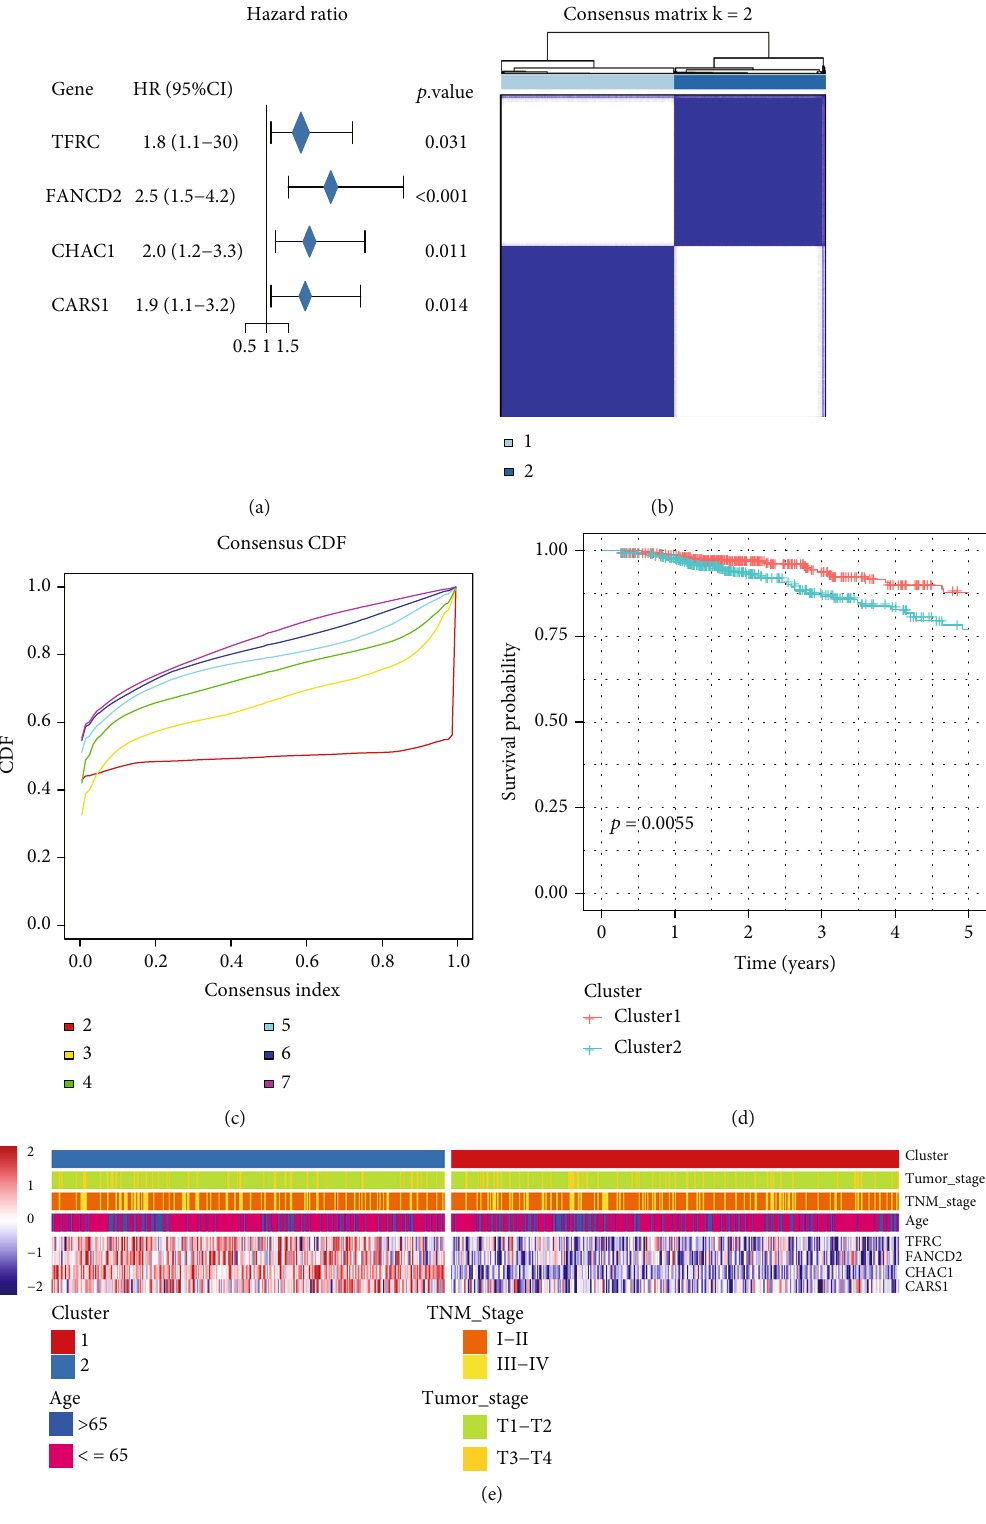
Figure 2: Identi fi cation of breast cancer subclasses using consensus clustering in the ferroptosis set. (a) Univariate Cox regression analysis. Forest plot of four signi fi cant ferroptosis-related genes associated with the overall survival in breast cancer in the TCGA-BRCA cohort. (b) Clustering using four ferroptosis-related genes. The patients were divided into clusters 1 and 2. (c) Empirical cumulative distribution function plot displaying consensus distributions for each k . (d) Survival analysis of the patients in clusters 1 and 2 in TCGA cohort. (e) The heat map shows the association of the clusters and clinical pathological features based on the four ferroptosis-related